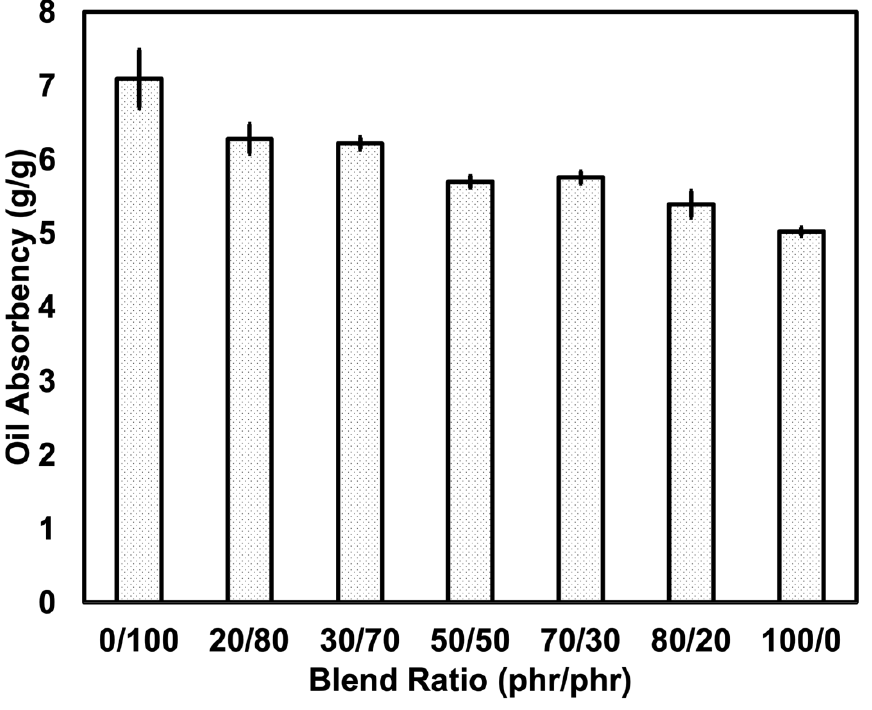
Figure 6. Oil absorbency of SR/NR blends at 72 h uptake.